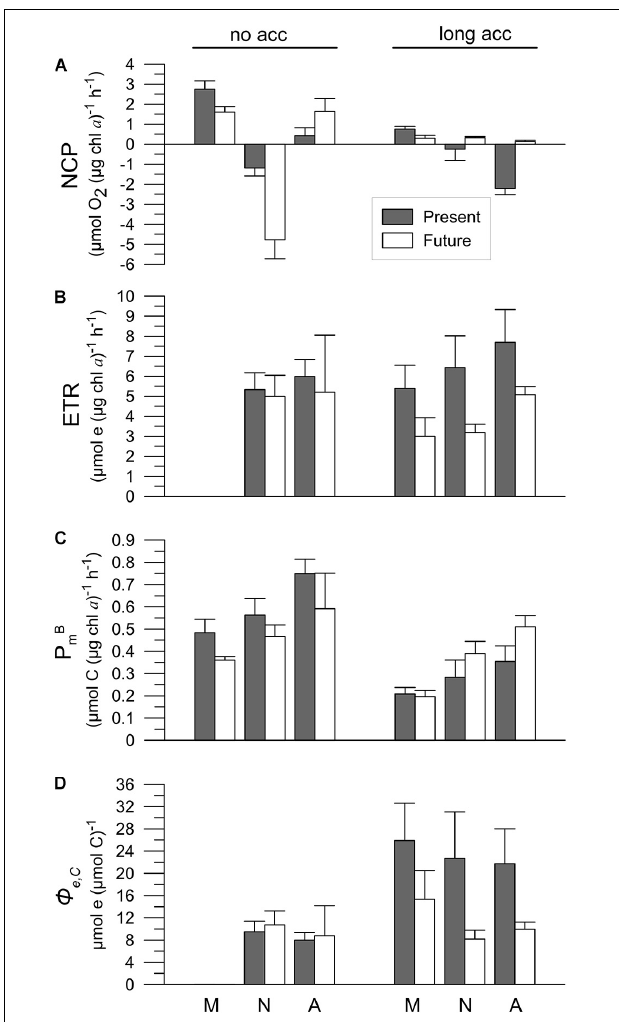
FIGURE 8 | (A) Net community productivity (NCP); (B) electron transport rates (ETR); (C) assimilation numbers (P mB ), and (D) ratio of ETR and P mB ( (cid:56) e , C ) of samples collected in Playa Unión (PU) after being acclimated for 1 and 5 days under the Present (Pres) and Future (Fut) scenarios. M, N and A letters indicate morning, noon and afternoon, respectively. Lines on the top of the bars indicate standard